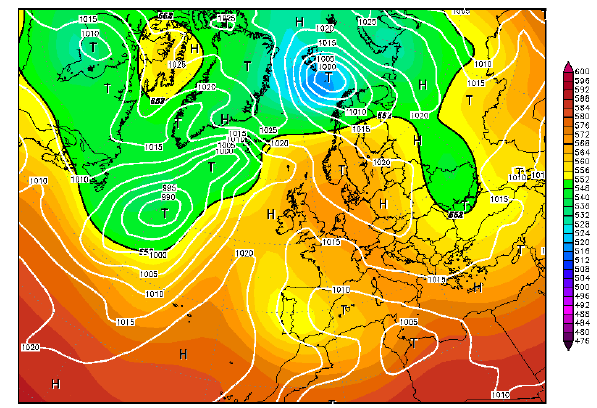
Fig. 6. Visual verification considering the maps of MM5’s QPFs and rainfall observations for all warning episodes during 2008. Figure 6. Visual verification considering the maps of MM5‟s QPF and rainfall 3 observations for all warning episodes during 2008. 4